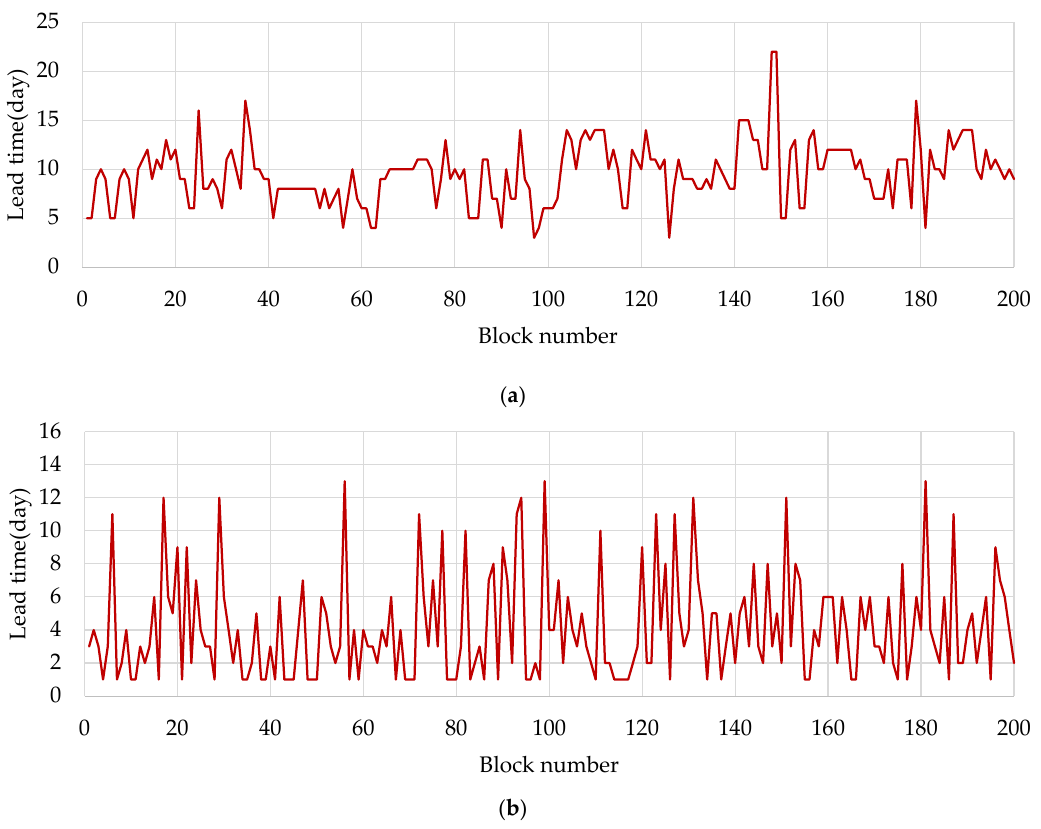
Figure 4. Original dataset of ( a ) block assembly process and ( b ) block pre-outfitting process.